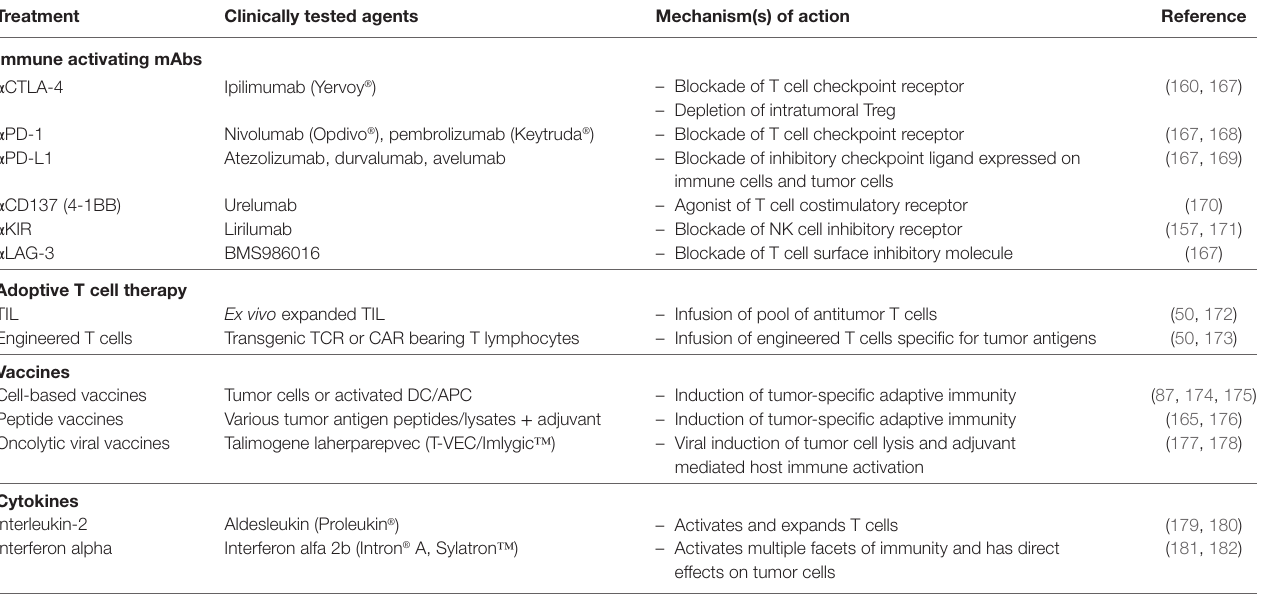
TABLe 1 | Key immunotherapeutics and their primary mechanisms of